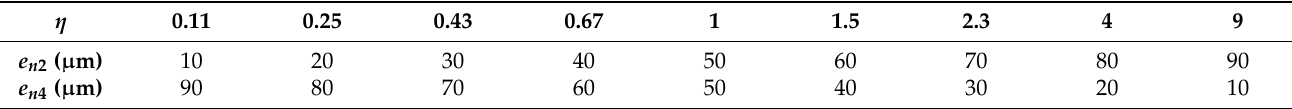
Table 2. Different asymmetry ratios between two insulating layers.